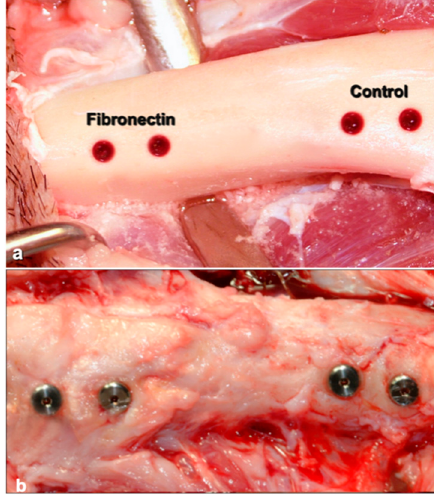
Figure 3. Example of implant site preparation: Untreated (control) or treated with Fibronectin ( a ). Implant sites, at 14 days, before sliced dissection ( b ).